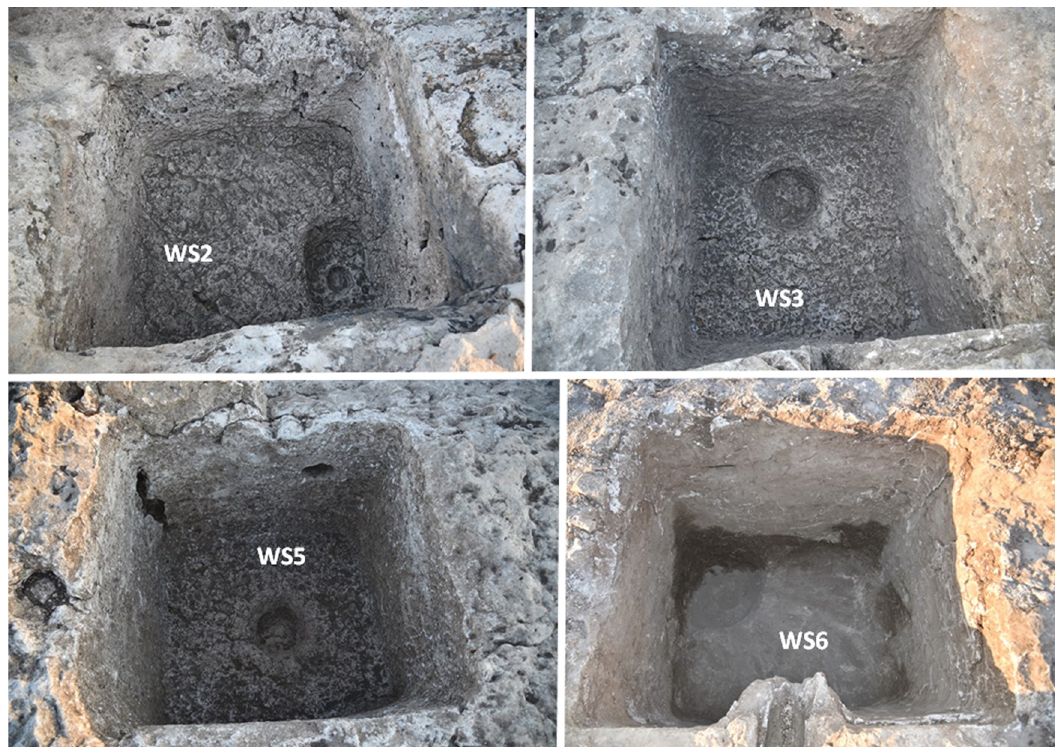
Figure 7: Oval or quasi - oblong pulp pits frequently carved in the collection pools ( Ambarçay Salvage Excavation Archive )